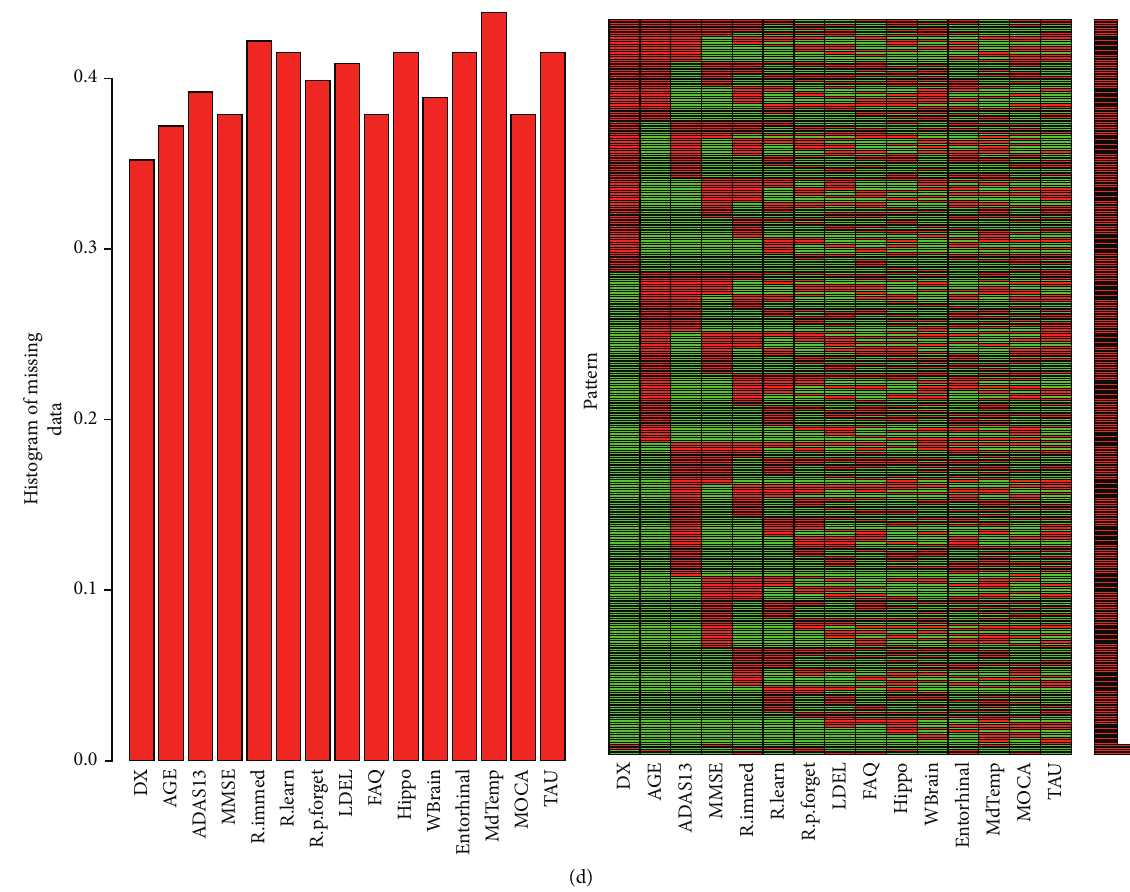
Figure 7: Missing data distribution under different data missing rates. (a) 10% data missing rates. (b) 20% data missing rates. (c) 30% data missing rates. (d) 40% data missing rates. Table 3: MAE values of the results of the five interpolation methods under different miss rates.